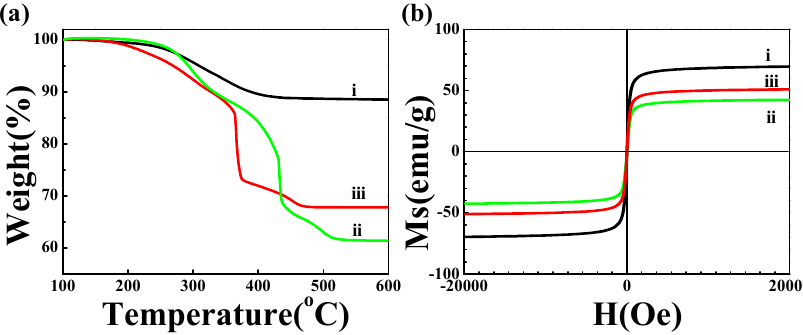
Figure 4. ( a ) TGA and; ( b ) VSM curves of (i) MSP; (ii) MSP@PNAMAm- p ; (iii) MSP@PNAMAm.